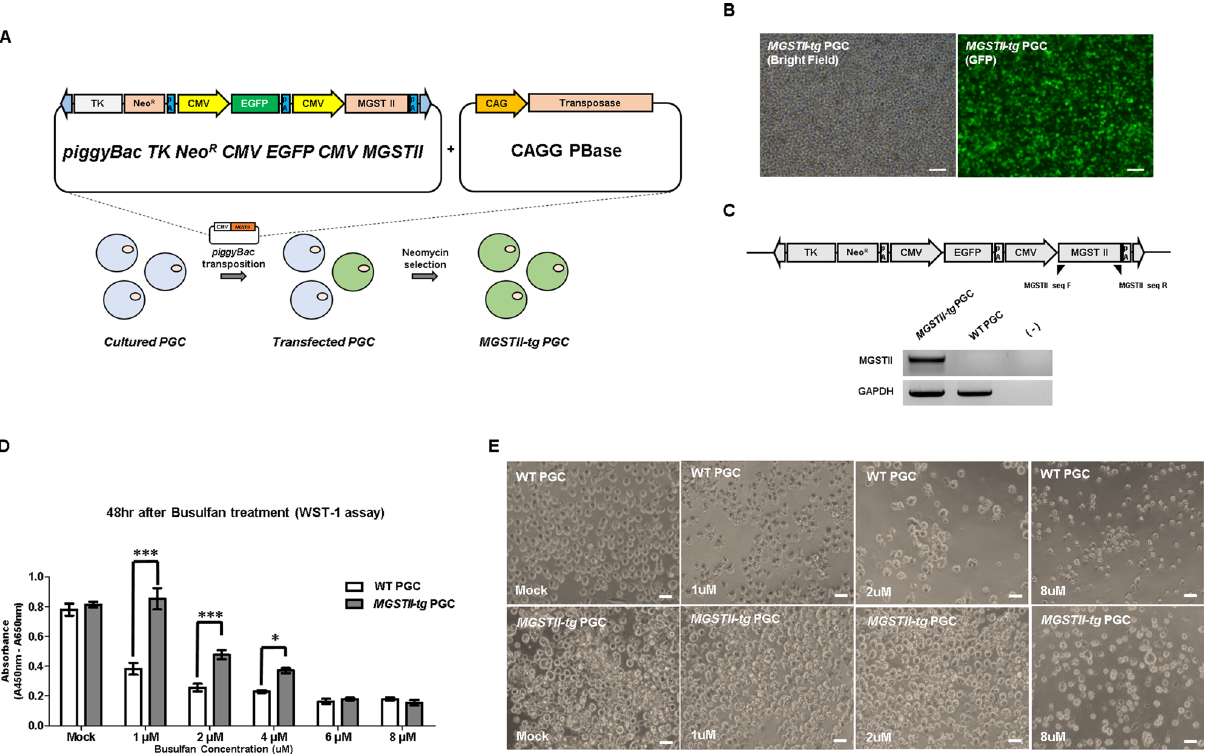
Figure 1. Establishment of the piggyBac CMV EGFP CMV MGSTII PGC cell line and validation of busulfan effect on MGSTII-expressing PGCs. ( A ) Schematic illustration of the piggyBac TK Neo R CMV EGFP CMV MGSTII vector with transposase and introduction into PGCs. Transgenic PGCs were selected with G418 for 30 days. ( B ) Establishment of the piggyBac TK Neo R CMV EGFP CMV MGSTII transgenic PGC cell line ( MGSTII-tg PGCs) after selection. Scale bars, 200 μm. ( C ) Genomic DNA PCR analysis of MGSTII-tg PGCs using MGSTII- and GAPDH- specific primers. Wild-type (WT) PGCs treated with distilled water (−) were used as control. ( D–E ) Dose-dependent effect of busulfan on MGSTII-tg and WT PGCs. ( D ) WST1 assay of PGCs after 48 h of dose-dependent busulfan treatment (mean ± SD; n = 3). * P < 0.05, ** P < 0.001. ( E ) Morphology of MGSTII-tg and WT PGCs in the presence of multiple busulfan dosages (0, 1, 2, and 8 μM). Vehicle control was treated with DMSO only. Scale bars, 50 GFP-tg PGCs and embryos injected with MGSTII-tg PGCs (Fig. 2B). However, in the busulfan-treated embryos, the number of migrated PGCs was dramatically decreased in embryos injected with GFP-tg PGCs relative to embryos injected with MGSTII-tg PGCs (Fig. 2B). The mean number of migrated gonadal PGCs in the left gonads of embryos injected with 1 μM busulfan-treated MGSTII -tg PGCs (174 ± 24.45) was significantly higher than not only in embryos injected with 1 μM busulfan-treated GFP-tg PGCs (9 ± 7.54), but also in embryos injected with untreated GFP-tg PGCs (88 ± 20.59) and untreated MGSTII-tg PGCs (112.67 ± 32.47). Similarly, the mean number of migrated cells in the right gonads of embryos injected with busulfan-treated MGSTII-tg PGCs (161 ± 33.08) was also significantly higher than in other groups (82 ± 24.06 in untreated GFP-tg PGCs, 58 ± 24.02 in untreated MGSTII-tg PGCs, and 4.3 ± 3.21 in busulfan-treated GFP-tg PGCs) (Fig. 2C). These results suggested that MGSTII-tg PGCs were resistant to busulfan in vivo, as demonstrated by in vivo migration activity. We also examined the survivability and hatchability of recipients after transfer of PGCs with busulfan treatment into embryonic blood vessels (at HH 13–16) (Supplementary Table 1). The survivability (at E6) and hatchability of recipients were 50% lower in the busulfan only-treated group that in the untreated control group. The survivability (at E6) and hatchability of recipients were not lower in the busulfan-treated/untreated groups injected with transgenic PGCs ( GFP-tg PGCs and MGSTII-tg PGCs) than in the busulfan only-treated group (Supplementary Table 1). These results suggest that busulfan does not directly affect the development or hatch- ing of recipient embryos.